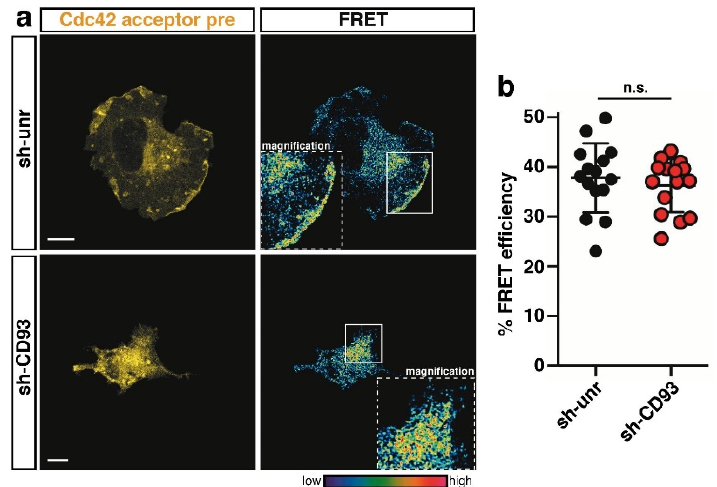
Figure 4. Cdc42 is not modulated by CD93 at the cell edge of adhering ECs. ( a ) FRET analysis on control (sh-unr) or CD93-silenced (sh-CD93) HUVECs transduced with a lentiviral construct expressing the Cdc42 biosensor. Cells were fixed at the early phase of adhesion to the ECM. Representative confocal images of transduced cells before photobleaching (acceptor pre) are shown. Rectangles indicate the photobleached cell area. Magnifications of the photobleached area are shown (1.6× sh-unr; 2.5× sh-CD93). The colored scale represents the color range of FRET efficiency. Scale bars, 10 μ m. ( b ) Graph showing the fluorescence increase (% FRET efficiency) upon photobleaching at the cell edge of early spreading ECs ( n = 15 cells for sh-unr and n = 15 cells for sh-CD93). Data are presented as scatter plot. n.s., not significant; Student t -test.